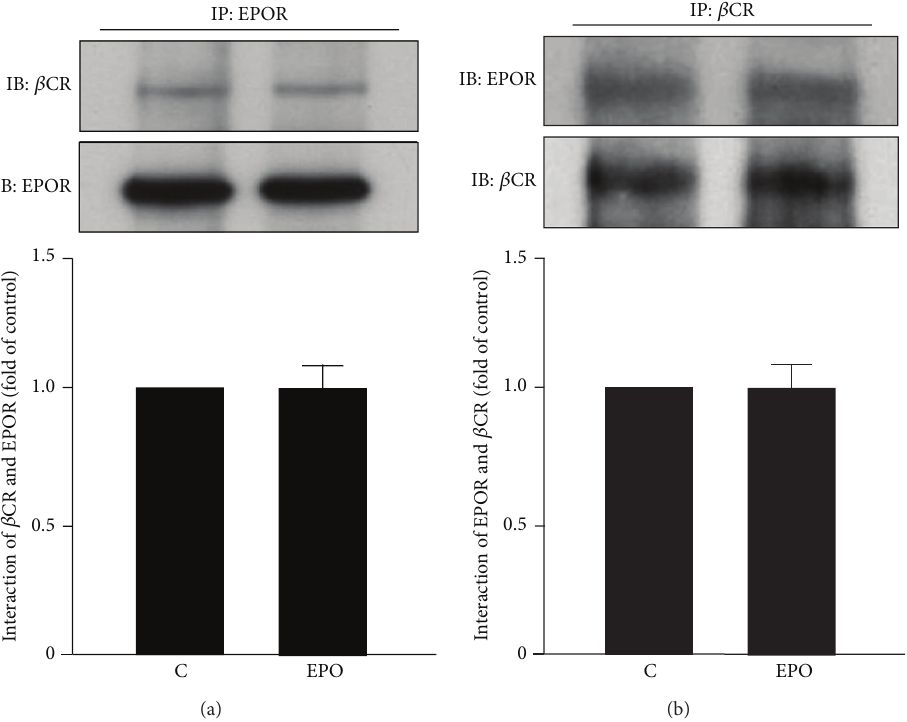
Figure 3: EPO treatment does not affect the interaction of 𝛽 CR and EPOR in macrophages. Macrophages were treated with or without EPO (5U/mL) for 10 min. Cellular lysates were immunoprecipitated (IP) with (a) anti-EPOR Ab or (b) anti- 𝛽 CR Ab and then were immunoprobed with anti-EPOR or anti- 𝛽 CR Ab by immunoblotting (IB). Data are mean ± SEM from 5 independent